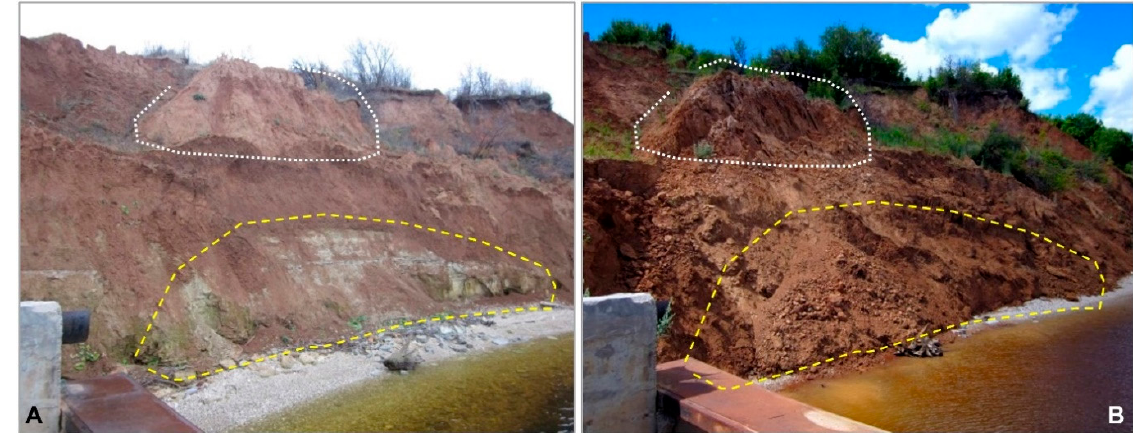
Figure 6. Site 1. Part of the study area in November 2013 ( A ) and June 2014 ( B ). The white line shows a block landslide, and the yellow line shows an abrasion scarp. Table 5. Quantitative indices describing the intensity of geomorphic processes at Site 1 according to scanning results. Observation Period